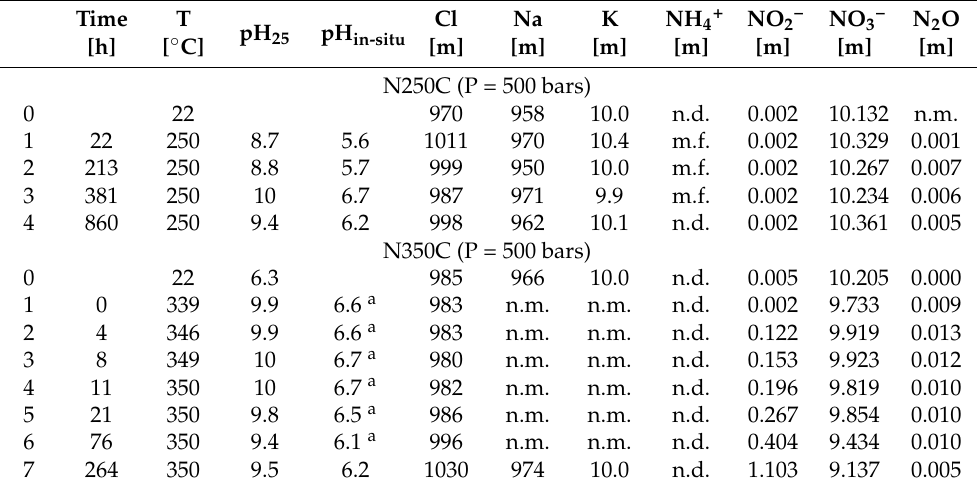
Table 2. Concentration of selected species measured in fluids from experiments in the H 2 O–NO 3 − system.